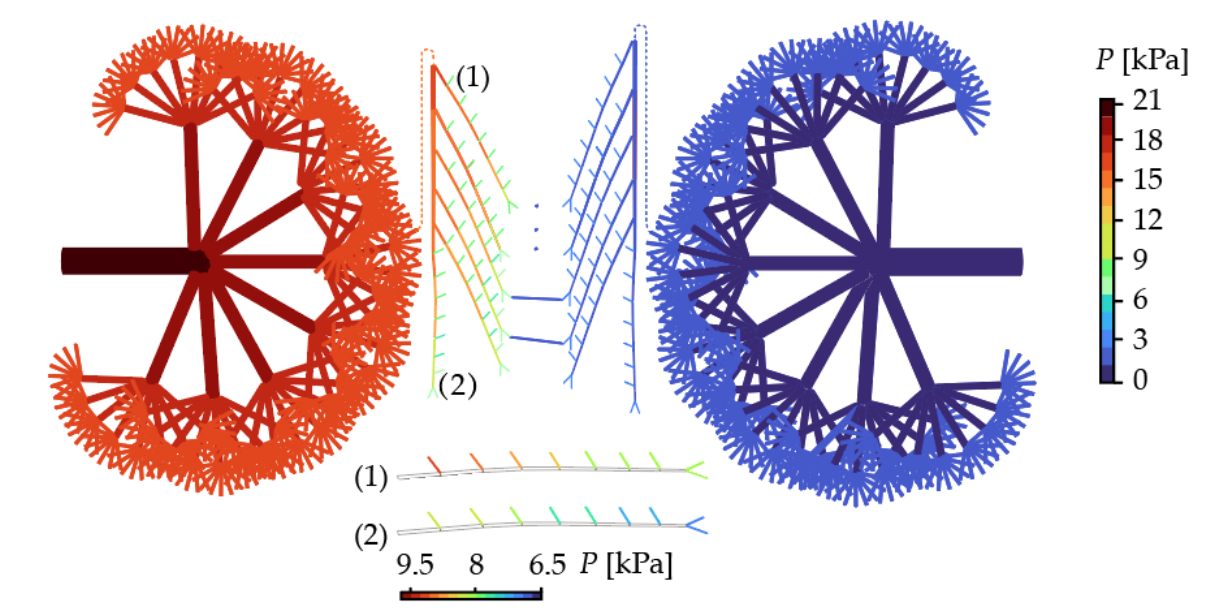
Figure 7. Same as Figure 4 but with 𝑃 inlet = 21 kPa.